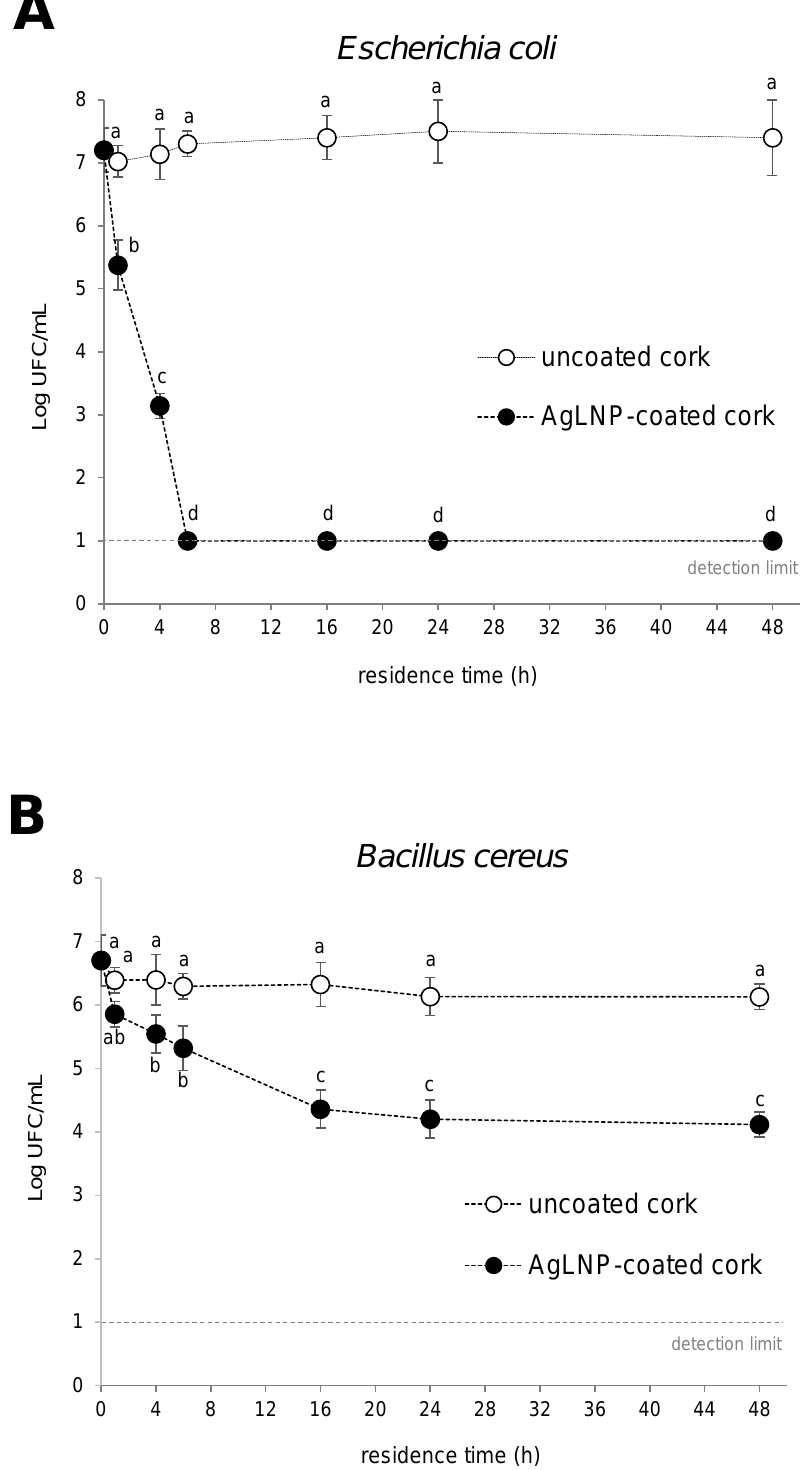
Figure 5. Antibacterial activity against E. coli ( A ) and B. cereus spores ( B ) of control uncoated- and AgLNP-coated cork acting as the filter medium in a point-of-use device for water disinfection. Different letters represent significant differences ( p < 0.05) between groups and at increasing residence time; e.g., “a” and “b” are statistically different from each other but not from “ab”. Data are reported as the mean value ± standard error (S.E.) from three biological replicates ( n = 3) derived from independent